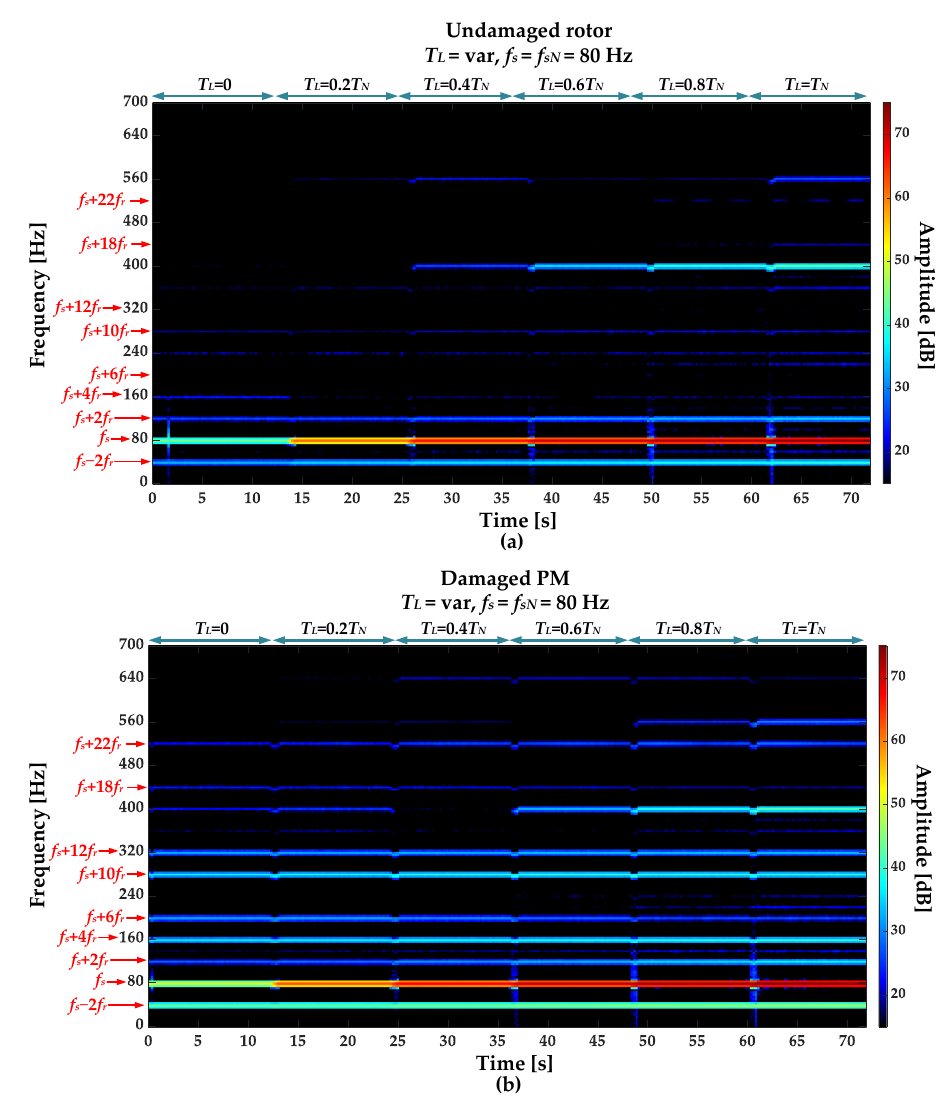
Figure 7. STFT spectrograms of the stator phase current component for ( a ) an undamaged rotor and ( b ) rotor with damaged PMs ( T L = var, f s = 80 Hz).